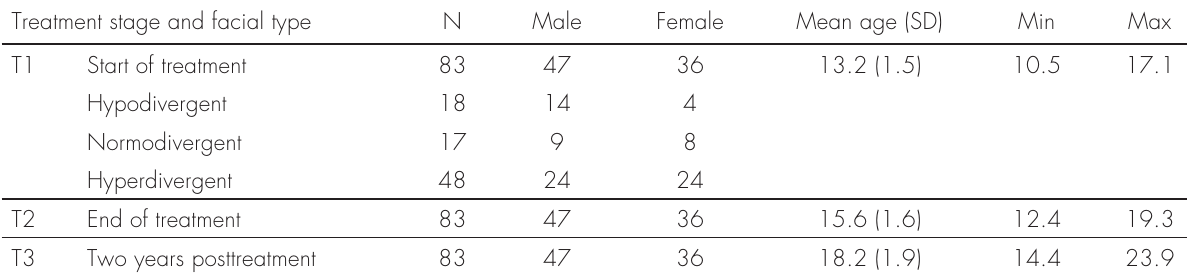
Table I. Sample distribution.